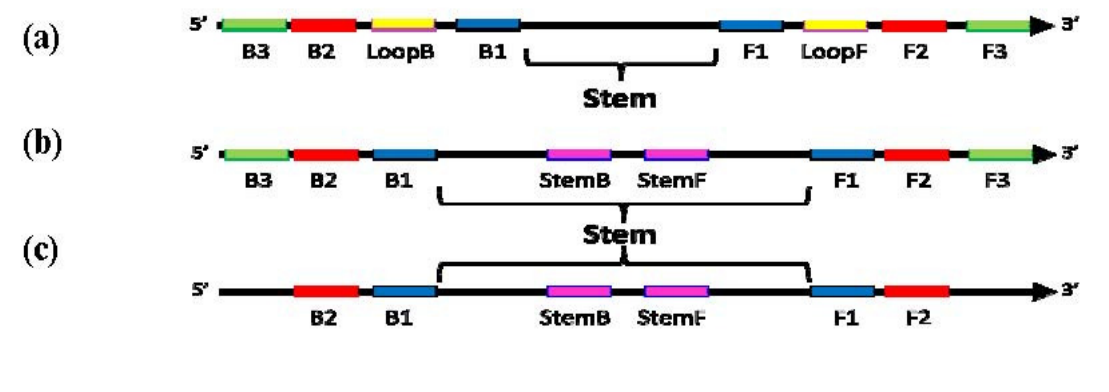
Figure 1. Schematic diagram showing locations of priming sites and the “Stem” in loop-mediated amplification (LAMP) with Loop primers ( a ), LAMP with Stem primers ( b ) and LAMP with Stem primers but without “Displacement primers” ( c